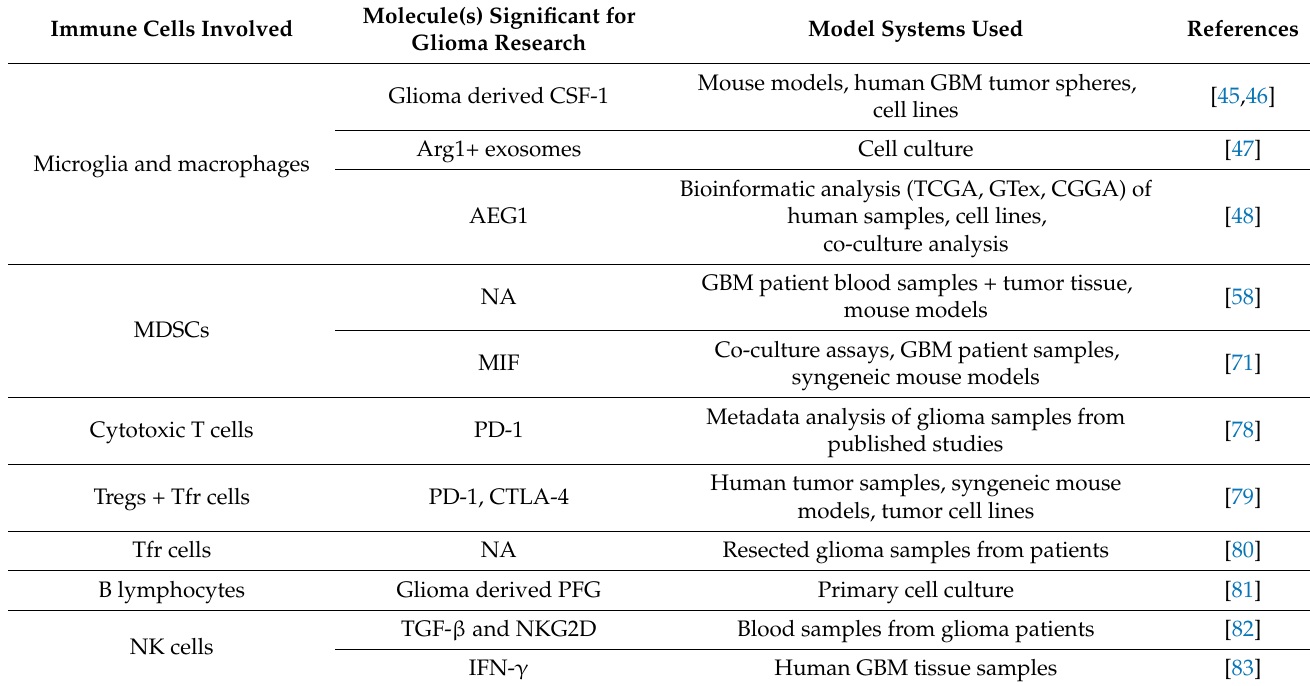
Table 1. Model systems used in pre-clinical glioma